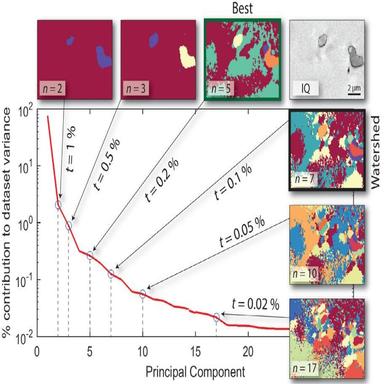
(a) Effect of varying variance rejection percentage on measured EBSD pattern and spectrum cross-correlation peak height with corresponding RC-EBSPs and RC-spectra. Colour is cross-correlation peak height. (b) and (c) show percentage of these EBSD and EDS cross-correlation peak heights greater or less than cut-off proportions of maximal correlation in that analysis. (d) and (e) show mean and standard deviation of the cross-correlation peak heights for EBSD, EDS and the quadrature combination of the two. (For